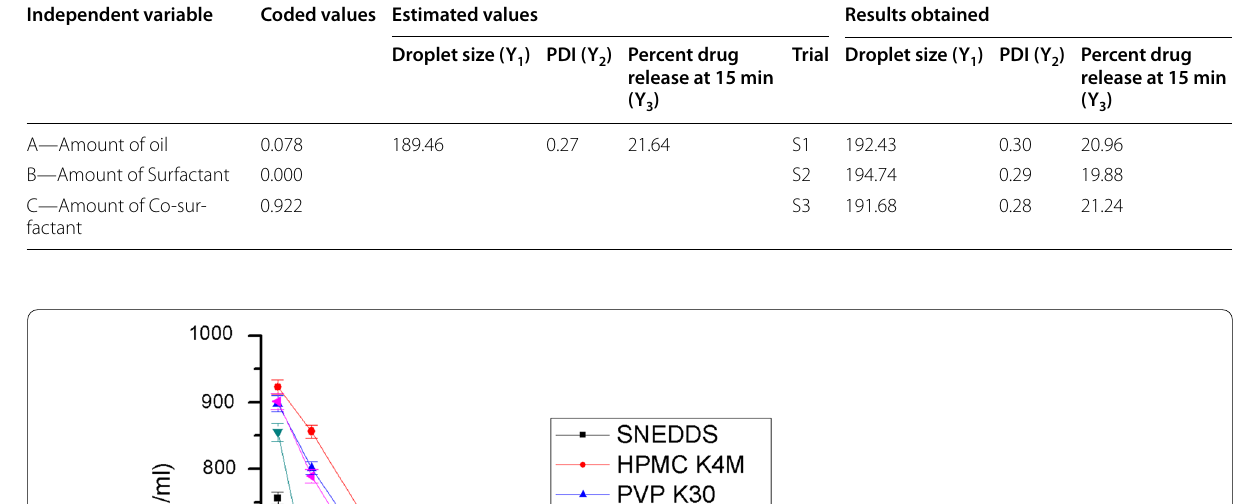
Table 4 Optimum conditions obtained by derringer’s desirability approach